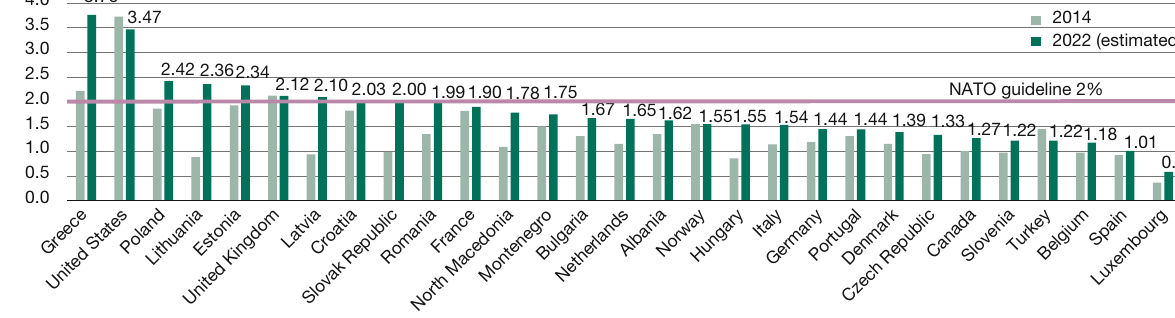
Source: NATO, Defence Expenditure of NATO Countries (2014-2022), Communique PR/CP(2022)10527, June